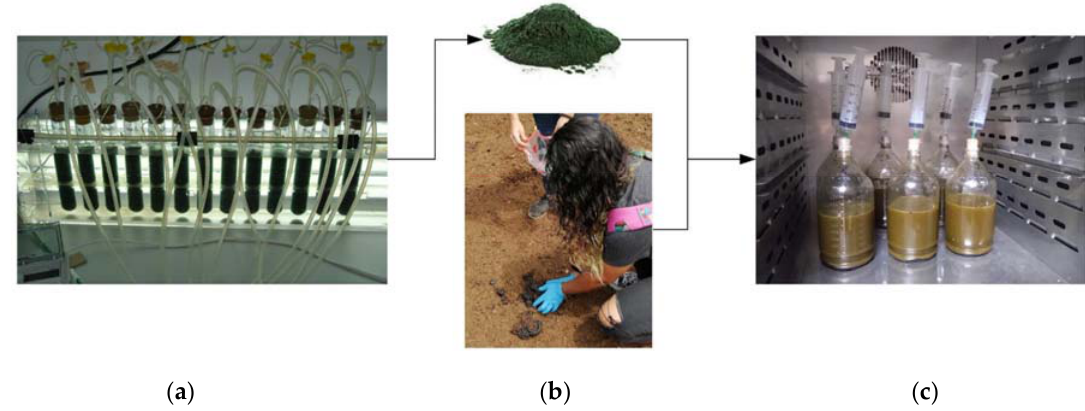
Figure 1. Flow diagram of the cultivation of cyanobacterial biomass and its anaerobic co-digestion: ( a ) Cultivation in column photobioreactors (PBRs) of Arthrospira platensis in wastewater from a dairy industry; ( b ) harvested and pre-treated cyanobacterial biomass, and raw cattle manure; ( c ) anaerobic co-digestion of cyanobacterial biomass and raw cattle manure in a mesophilic regimen (35 ◦